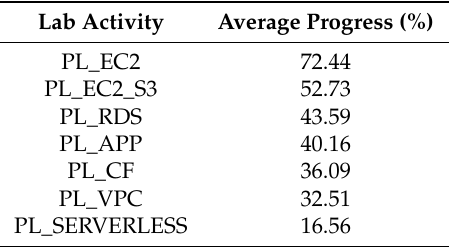
Table 3. Average percentage of progress of the students in each lab activity. Activities are shown in the table in chronological order of appearance in the course material from left to